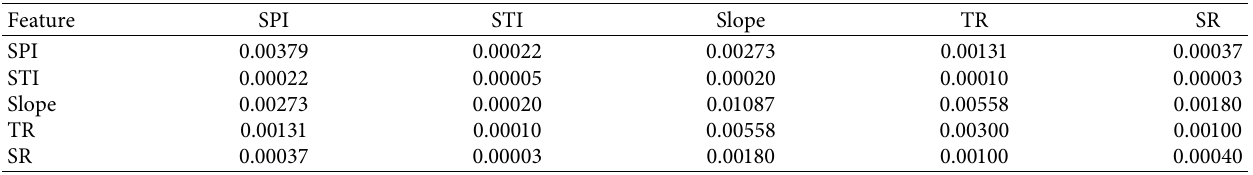
Figure 16: Terrain ruggedness and CLs of the sample area. Table 4: The covariance matrix of terrain factors.